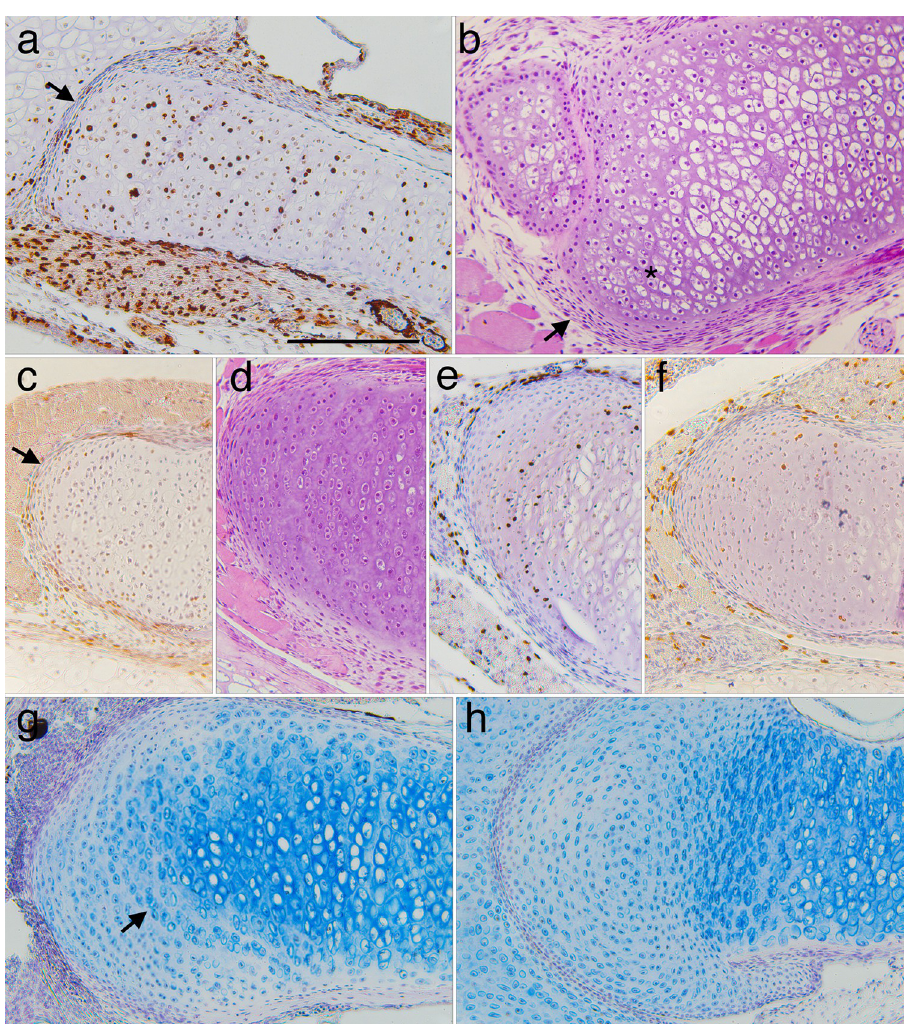
Fig 9. Frontal sections of the distal region of left lower jaws showing metamorphic changes in histology, shape and cell features. Right is to the front of the head and up is to the lateral side. (a) a late larval specimen (NF 58) showing BrdU labeling in transversely aligned cell clusters inside the cartilage, and the jaw joint with the palatoquadrate (arrow), which lies in the plane of the long axis of the cartilage at larval stages. (b) a resin embedded, H&E stained section at NF 59 (the smaller cartilage is the palatoquadrate) showing matrix and clusters of round chondrocytes near the distal end ( � ) and a layer of flattened cells outside the distal end (arrow). (c-f) a series from NF 61 to 64+ specimens showing the emergence of rows of small chondrocytes aligned with the distal end (arrow in c). BrdU labeling (c, e and f) remains low in perichondral cells, the newly emerging chondrocytes, and the larger, more proximally situated chondrocytes of the original larval cartilage. (g) a NF 67 specimen showing light Alcian blue staining of matrix around the outermost rows of new chondrocytes, strong staining around the larger, more proximally positioned chondrocytes, and moderate staining around the innermost row of new chondrocytes (arrow), which are larger and more circular than in outer rows. (h) the head of a humerus from the same specimen as g showing a similar pattern of chondrocytes and matrix staining. Scale bar is 0.2